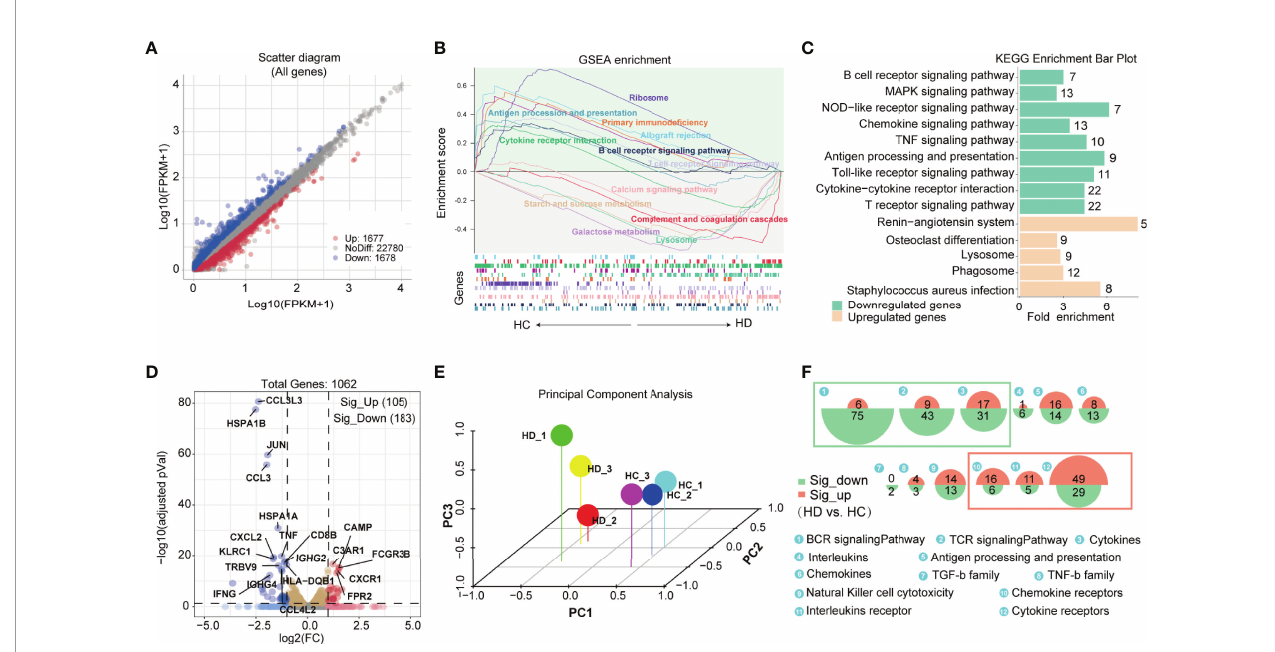
FIGURE 1 | Features of immunological genetic changes in PBMC of HD patients based on bulk RNA-seq data. (A) Identi fi cation of differentially expressed genes (DEGs) between HC and HD groups. Adjusted P value < 0.05 and |Log2FC| > 0.25 were used as screening criterion. Blue and red dots represent down-regulated and up-regulated genes in the HD group, respectively. (B) Gene set enrichment analysis of DEGs. Up: curves of the change (increase/decrease) in the enrichment score values of the prede fi ned gene sets in different functional units across the cumulative process. Each line indicates one functional unit marked with a speci fi c color; Down: location of the gene members of the prede fi ned gene set in the functional units, with arrows showing the direction of enrichment in the HD and HC groups. Functional units associated with immune function ( P < 0.05) are presented in the picture. (C) KEGG analysis of down-regulated and up-regulated genes. The green and orange bars show the pathways enriched by the down-regulated and up-regulated genes, respectively. The Arabic numbers on the right indicate the number of differential genes in the corresponding pathway. (D) Volcano plot showing immune-related genes differentially expressed between groups. Red dots and blue dots represent up-regulated and down-regulated immune genes in the HD group, respectively. (E) Principal component analysis based on the immune gene matrix. One dot represents one sample. (F) Proportional area chart showing the number of differential genes in the corresponding immuno-in fl ammatory pathway. The areas of the green and orange circles show the number of down-regulated and up-regulated genes, respectively. PBMC, peripheral blood mononuclear cell; DEGs, differentially expressed genes; KEGG, Kyoto encyclopedia of genes and genomes; HD, hemodialysis; HC, healthy